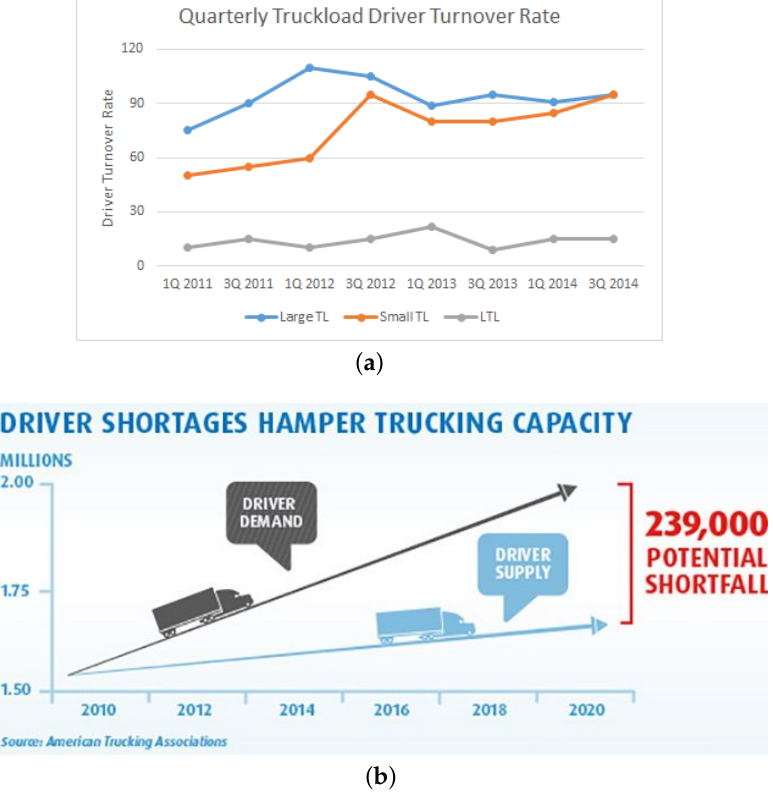
Figure 2. One key concern of today’s logistics is the long driving and away-from-home time of truck drivers, which results in ( a ) higher turnover rates [13] and ( b ) driver shortages